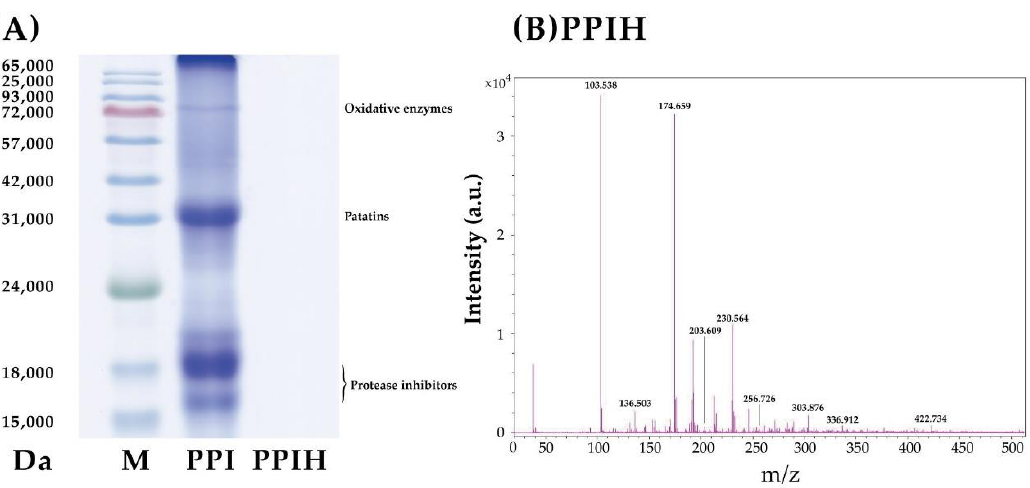
Figure 4. SDS-PAGE ( A ) and mass spectrometry analysis ( B ) of PPI and PPIH. M: MW standard.